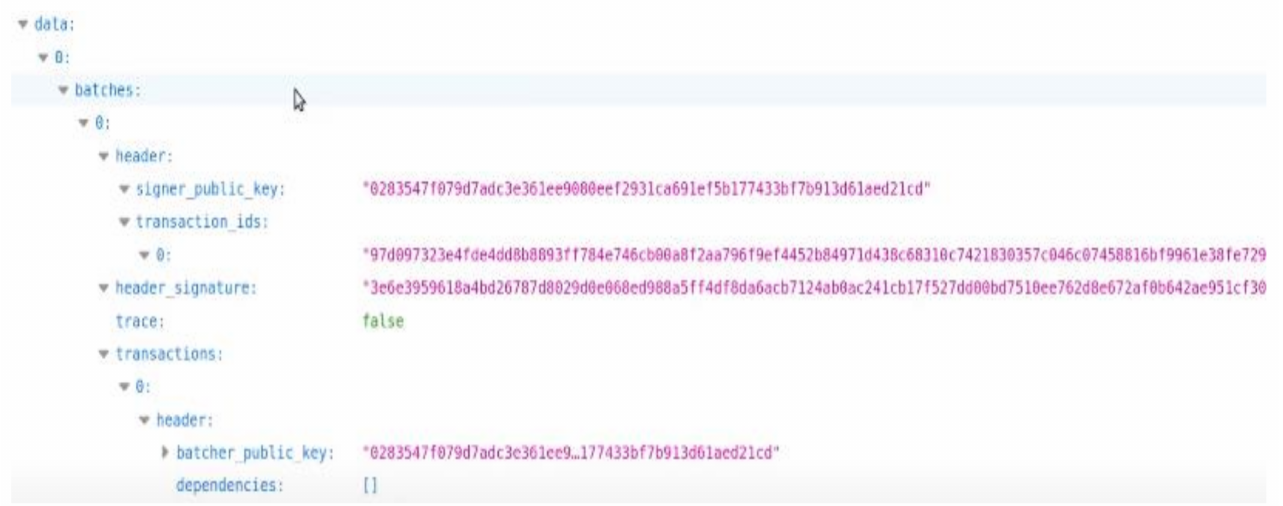
Figure 9. Batch wise hash-encrypted node transactions (addNode()).